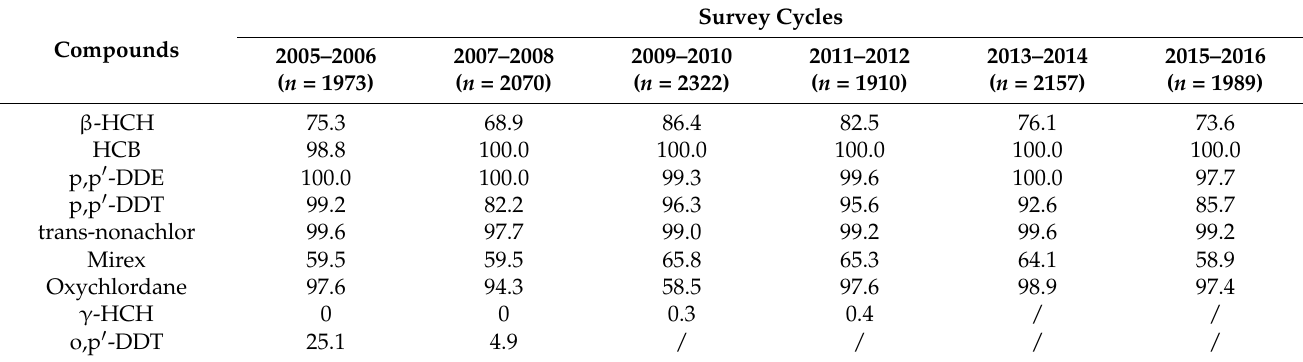
Table 1. Detection frequency (%) of OCPs by Survey Cycles.